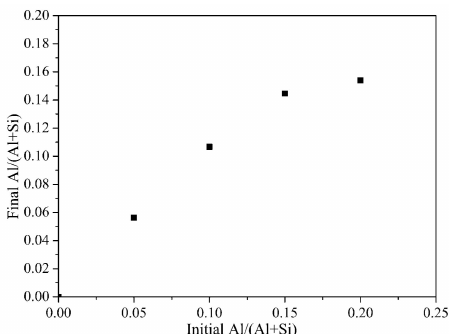
Figure 3. Correlation between initial Al / (Al + Si) molar ratio in reaction slurries and averaged final Al / (Al + Si) molar ratio detected by EDS.